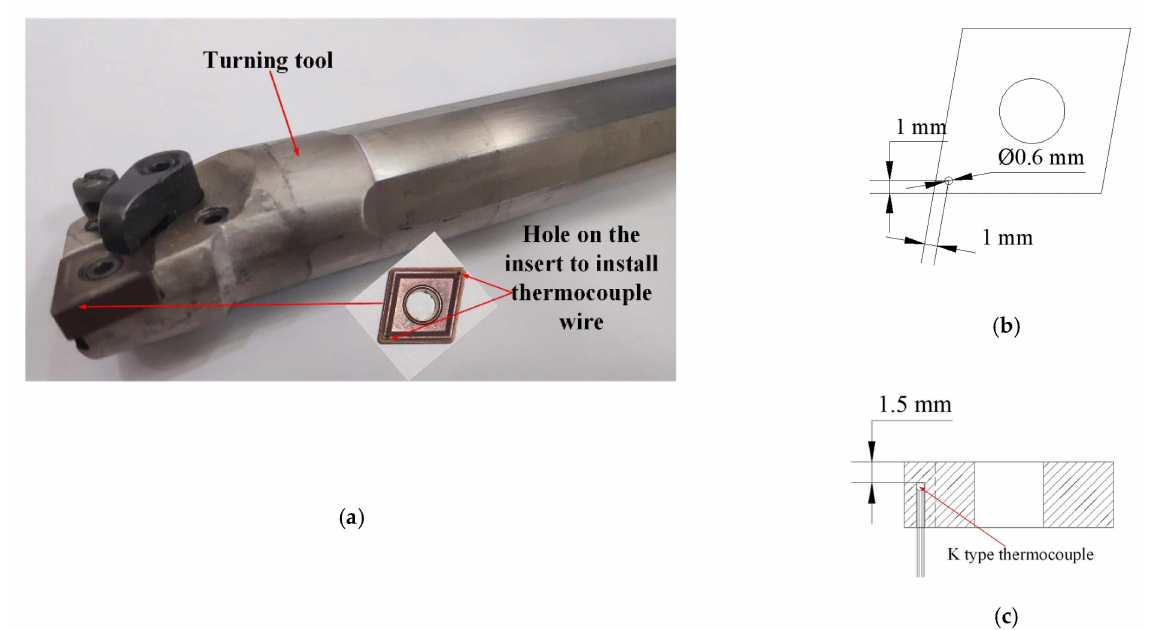
Figure 10. The manufactured internal spray cooling turning tool and thermocouple position. ( a ) the internal spray cooling turning tool, ( b ) diagram of distance between thermocouple and main and minor cutting edges, ( c ) diagram of the distance between the thermocouple and the rake face.